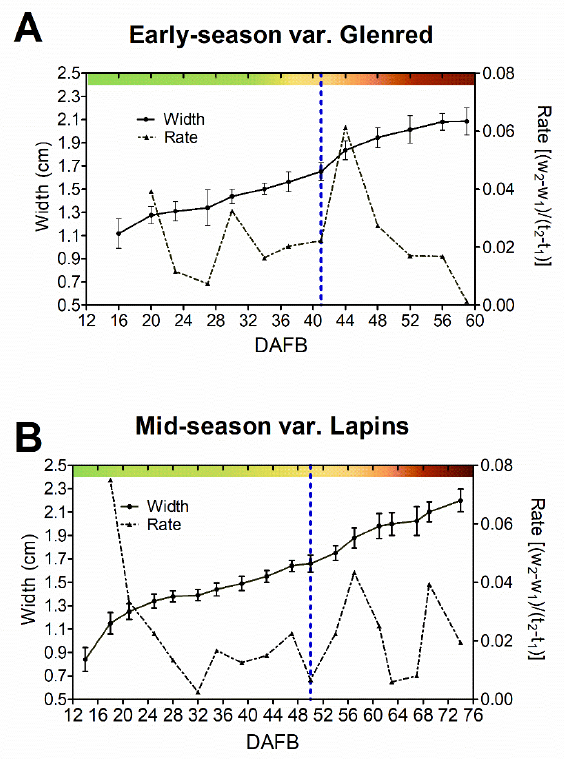
Figure 1. Fruit growth and growth rate curves of early-season variety, Glenred ( A ) and mid-season variety, Lapins ( B ). A color scale is included based on fruit phenology (Tables S1 and S2). Growth resumption prior to fruit color change is indicated with a dotted blue line, 20 fruits from Lapins and Glenred were randomly selected for measurements. Data as ± SEM. DAFB, days after full